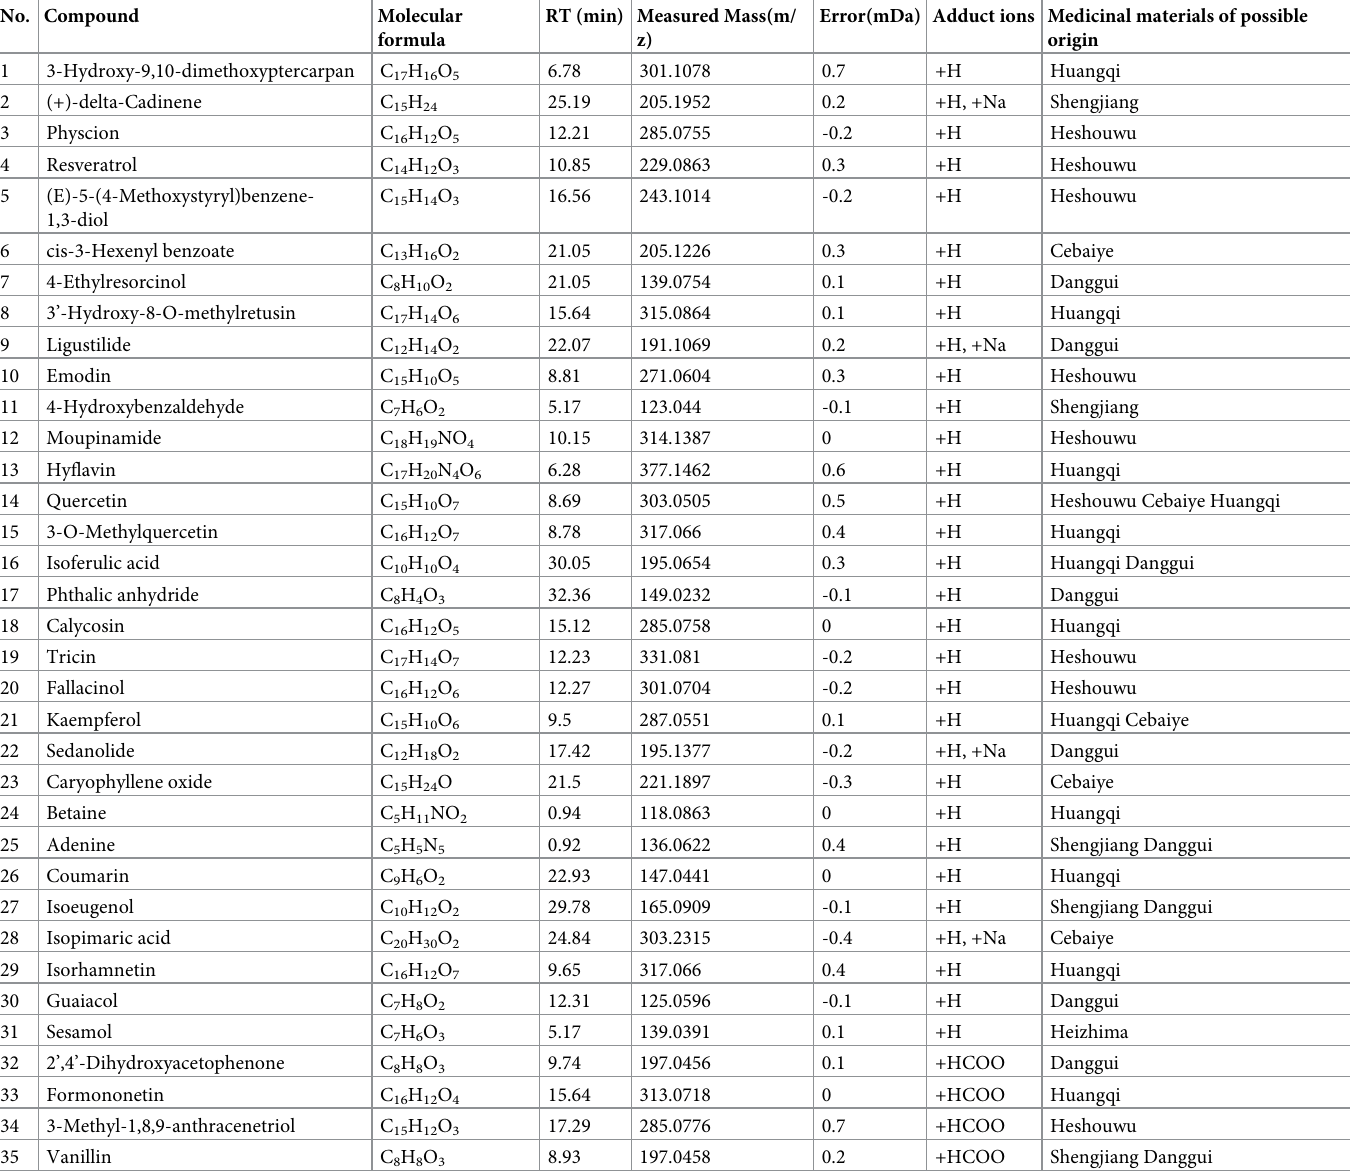
Table 2. Identification of the chemical constituents of